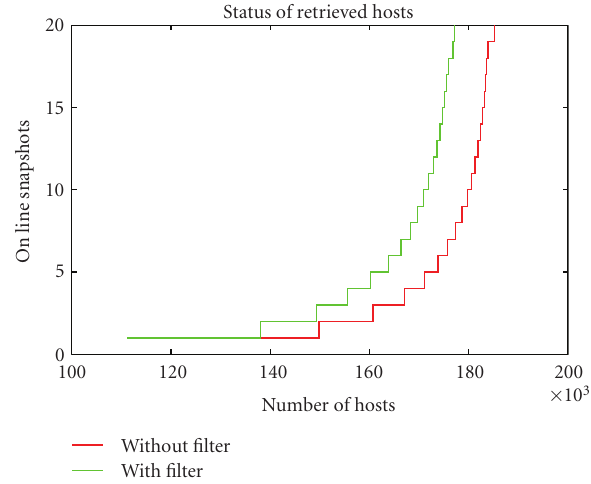
Figure 8: The results from crawlers with and without the filter.